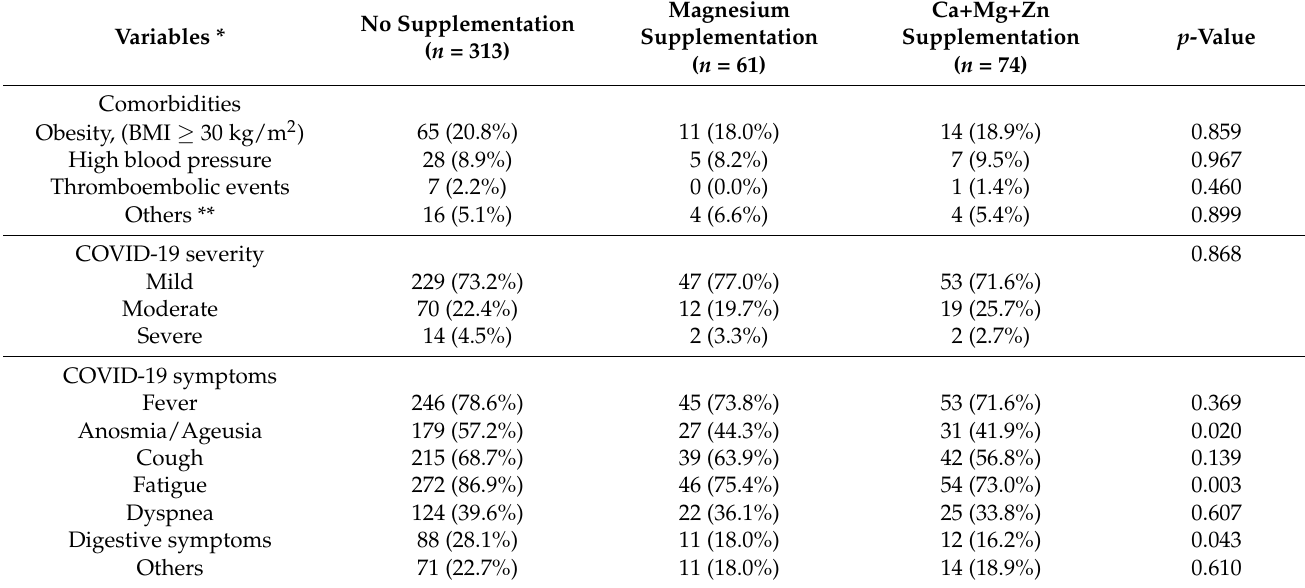
Table 3. Clinical characteristics, complications, and outcomes of the study cohort, stratified by type of micronutrient